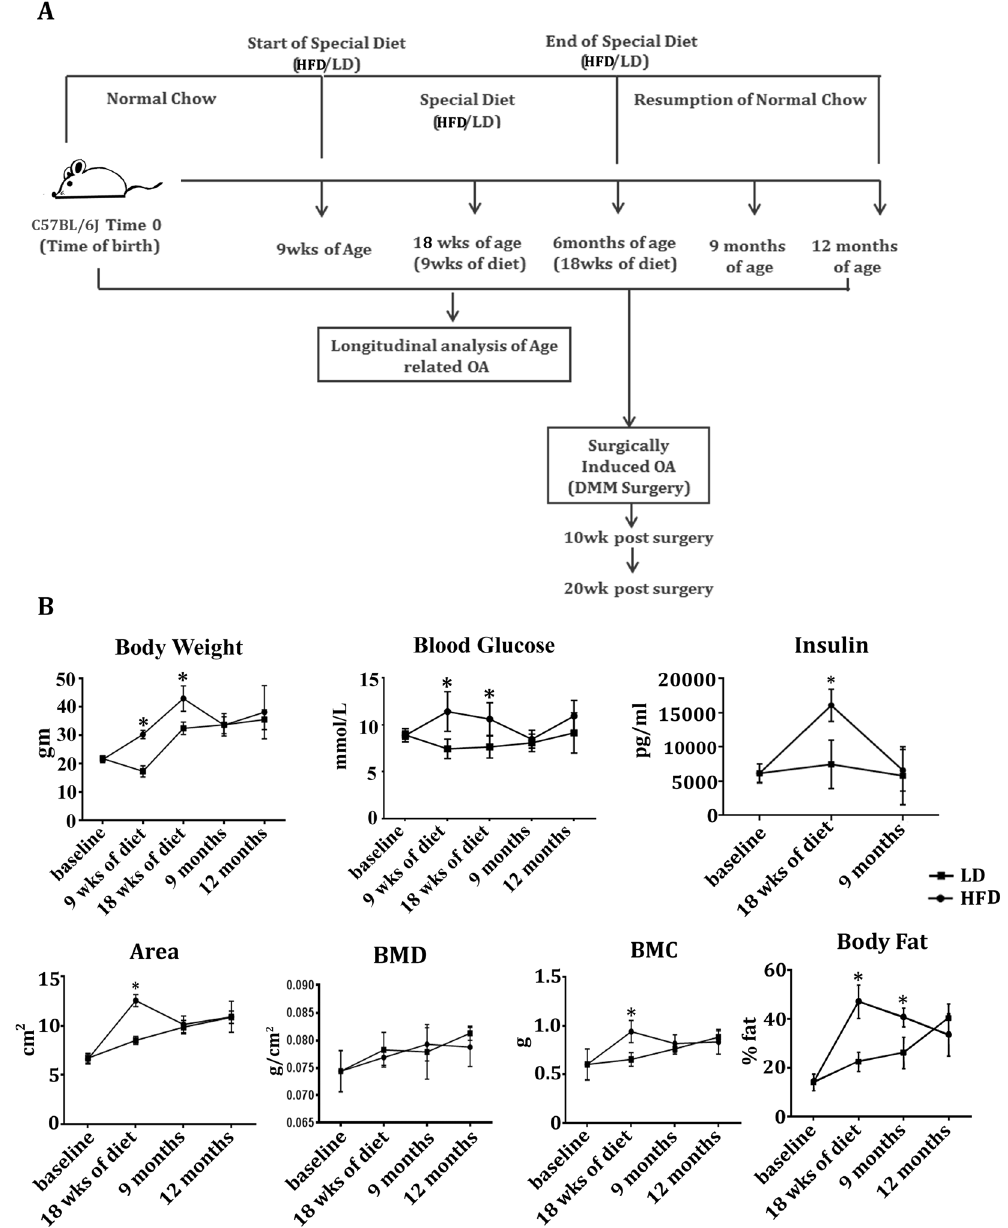
Figure 1. High fat diet promotes weight gain, hyperglycemia, hyperinsulemia and changes to body composition. ( A ) Schematic diagram showing diet regimes of high fat diet- (HFD), lean diet- (LD) and normal chow-fed mice, and the longitudinal timing for analysis of age related and surgically-induced OA. ( B ) Nine- week old C57BL/6J mice were placed on high fat diet or lean diet until 18 weeks (6 months of age) at which time the mice were returned to a normal chow diet up to 12 months of age. Body weight, fasting blood glucose, insulin levels, body area, bone mineral density (BMD), bone mineral content (BMC) and body fat percent were determined longitudinally. All results are expressed as mean ± SD. Data were analyzed by Two-way ANOVA followed by Holm-Sidak multiple comparison tests. * p < 0.05 (LD vs HFD at each time point); n =